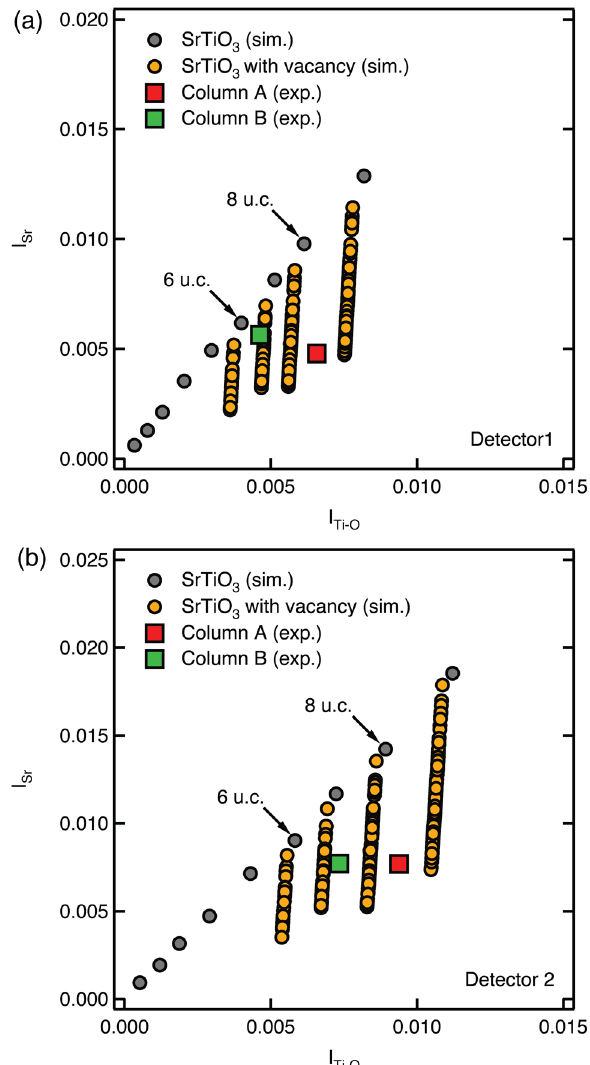
FIG. 2. Determination of vacancy configurations. (a,b) Simu- lated I vs I plots using detector angular ranges correspond- Sr Ti-O ing to detectors 1 and 2. Red and green squares represent the intensities from columns A and B, respectively, while orange circles are the simulated data points for all possible vacancy configurations.